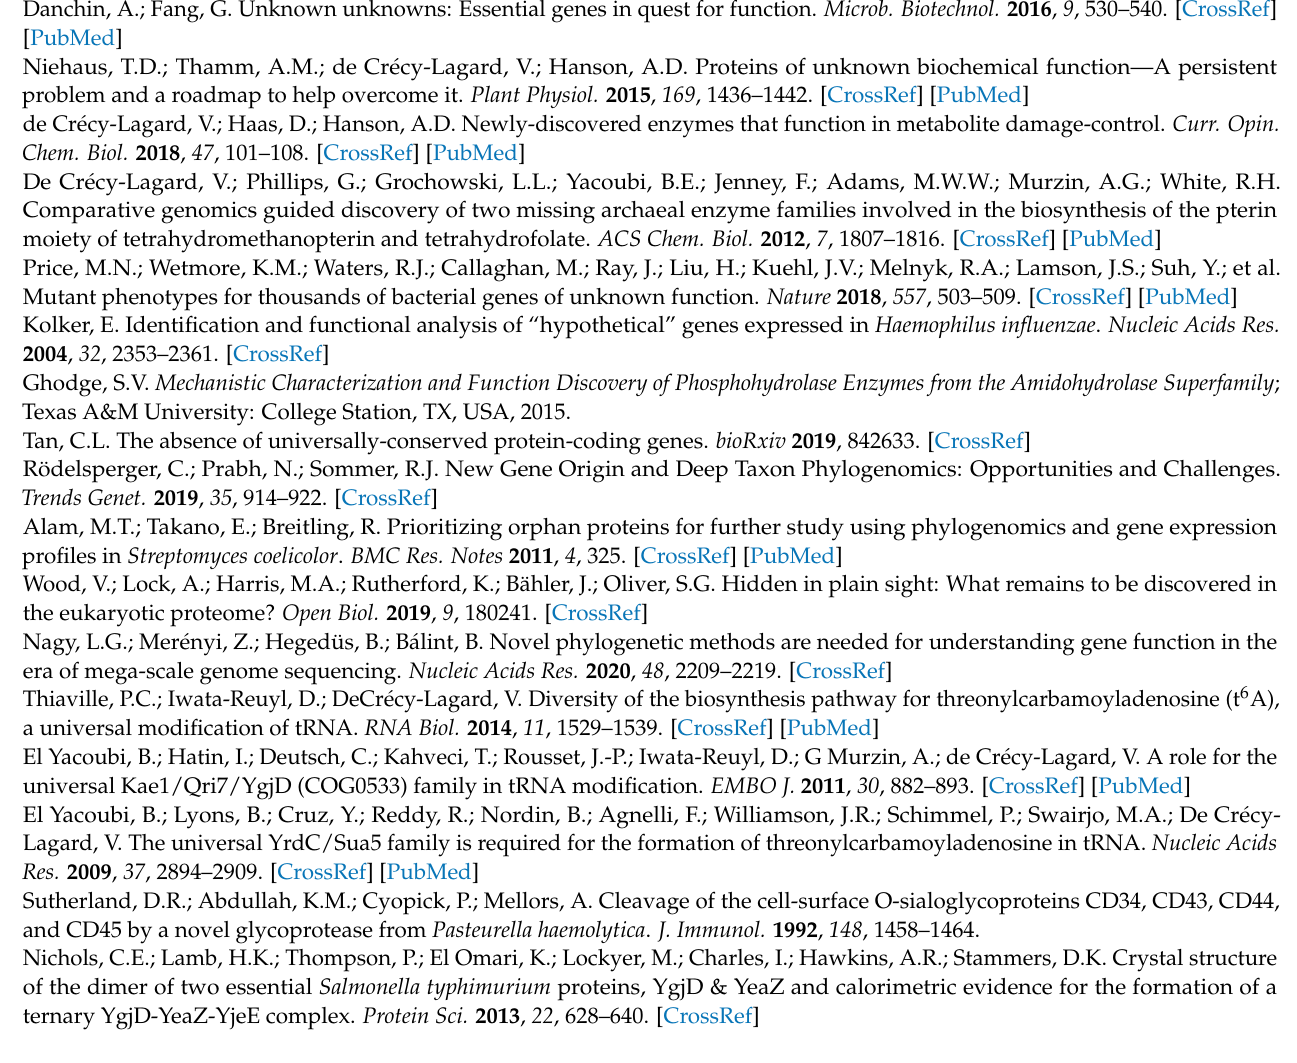
Data Table S6: “IMG-occurrence” data sheet; Data Table S7: Physical clustering keyword frequency analysis (PCKFA) and representative operons; Data Table S8: Representative operon metal-binding protein abundance; Data Table S9: CoXPresDb (Eukaryota) exports of the top 300 co-expressed genes of DUF34; Data Table S10: Co-regulated genes of Homo sapiens DUF34 homolog; Data Table S11: Concatenated list of sequences indicated to be possible non-canonical fusions of the DUF34 family; Data Table S12: STRING network export generated following the results of Data Table